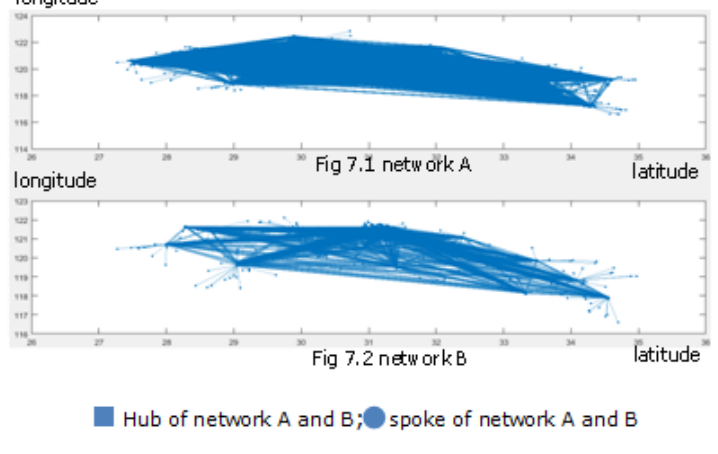
Figure 7. The hub and spoke network in the southern region, r = 1,  = 15